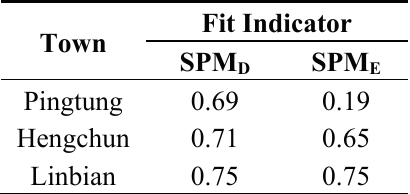
Table 1. Comparison of overlapping villages between WASH123D, SPM D , and SPM E using the performance